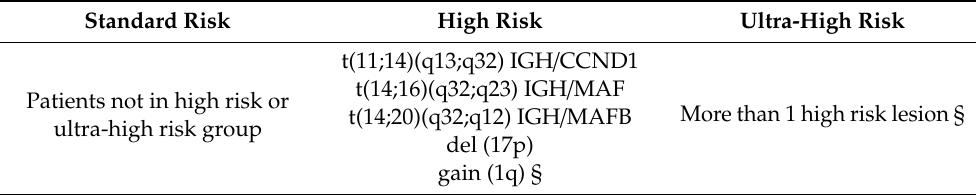
Table 2. Risk stratification of MM based on karyotype abnormalities, as reported in recent clinical